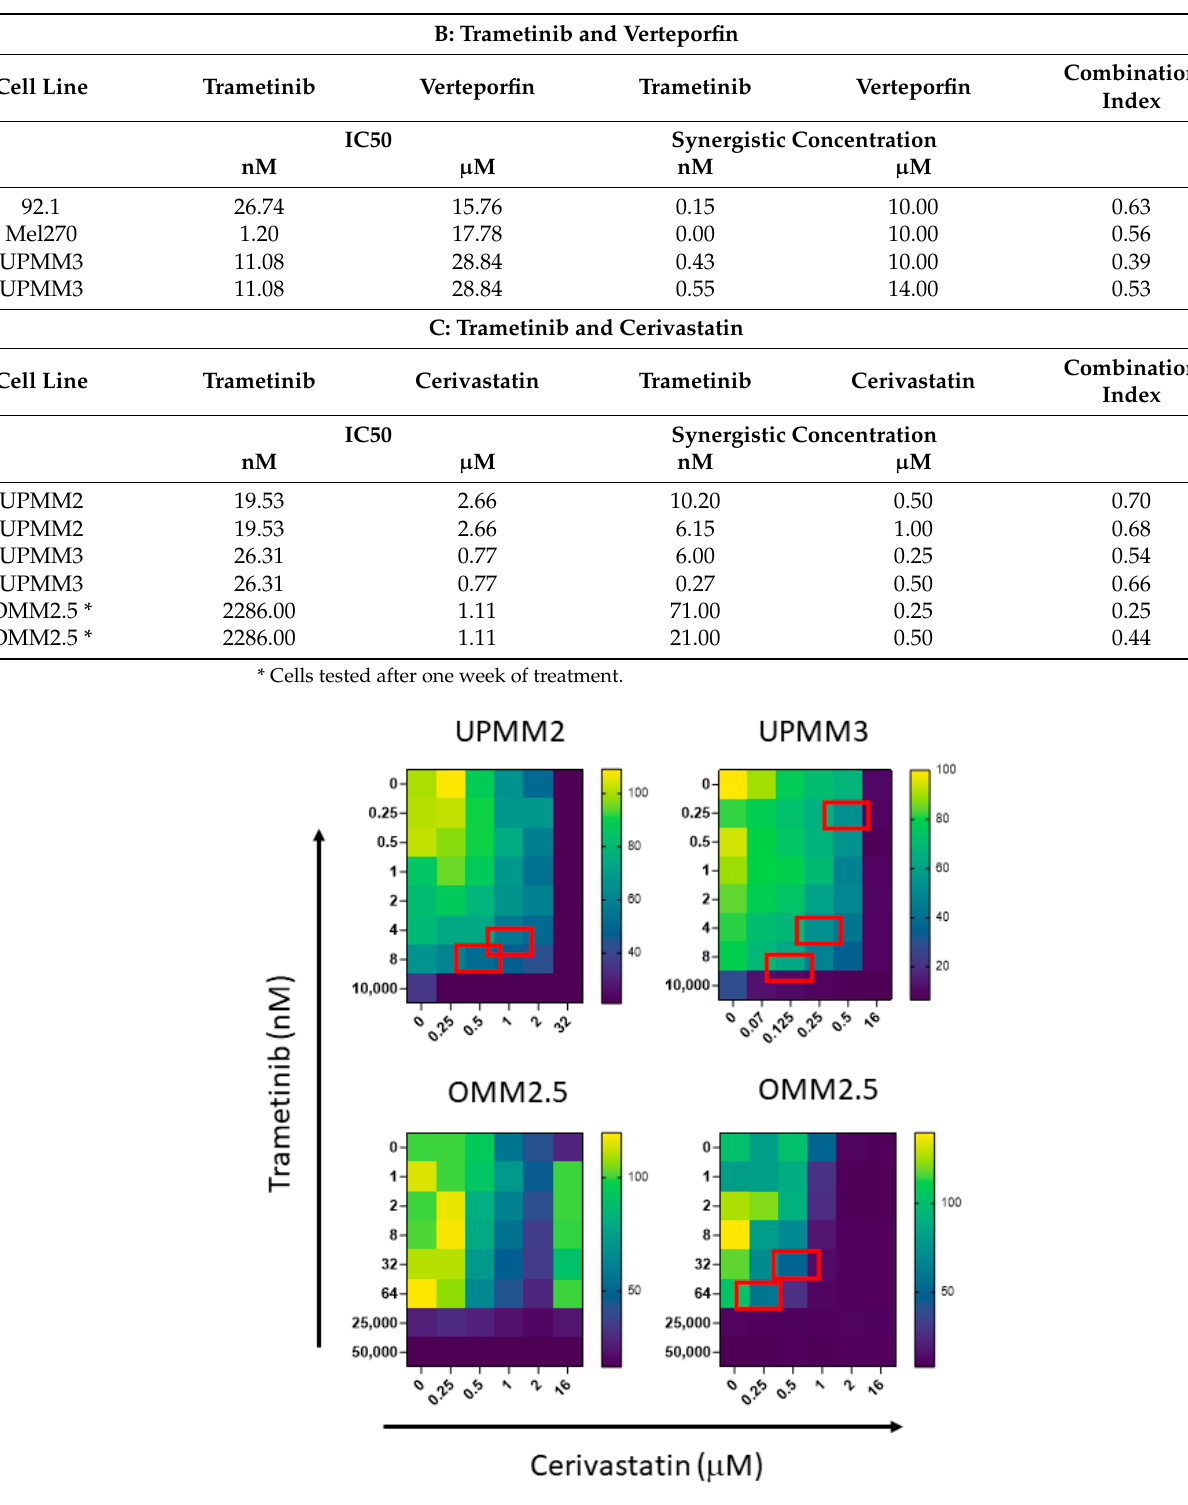
Figure 1. Minimal dose–response matrices showing trametinib-based combinations with cerivastatin by MTT assay. Synergistic combinations as calculated using the Chou–Talalay method are indicated by red boxes. Cell viability is reported by a colour code ranging from yellow (100%) to dark blue (<20%) as indicated by the bar on the right. OMM2.5 were tested at 72 h (lower left) and one week (lower right) of treatment. Table 3. Synergisms of trametinib with VPA (A), verteporfin (B) and cerivastatin (C) are shown. UM cell lines were treated for 72 h or seven days (*). The IC50 concentrations are reported as well as the minimum concentrations at which synergism was observed (synergistic concentration). The combi- nation index was calculated according to Chou–Talalay (see text). A combination index < 1 indicates synergism. Only data for cell lines for which synergism could be observed are shown.